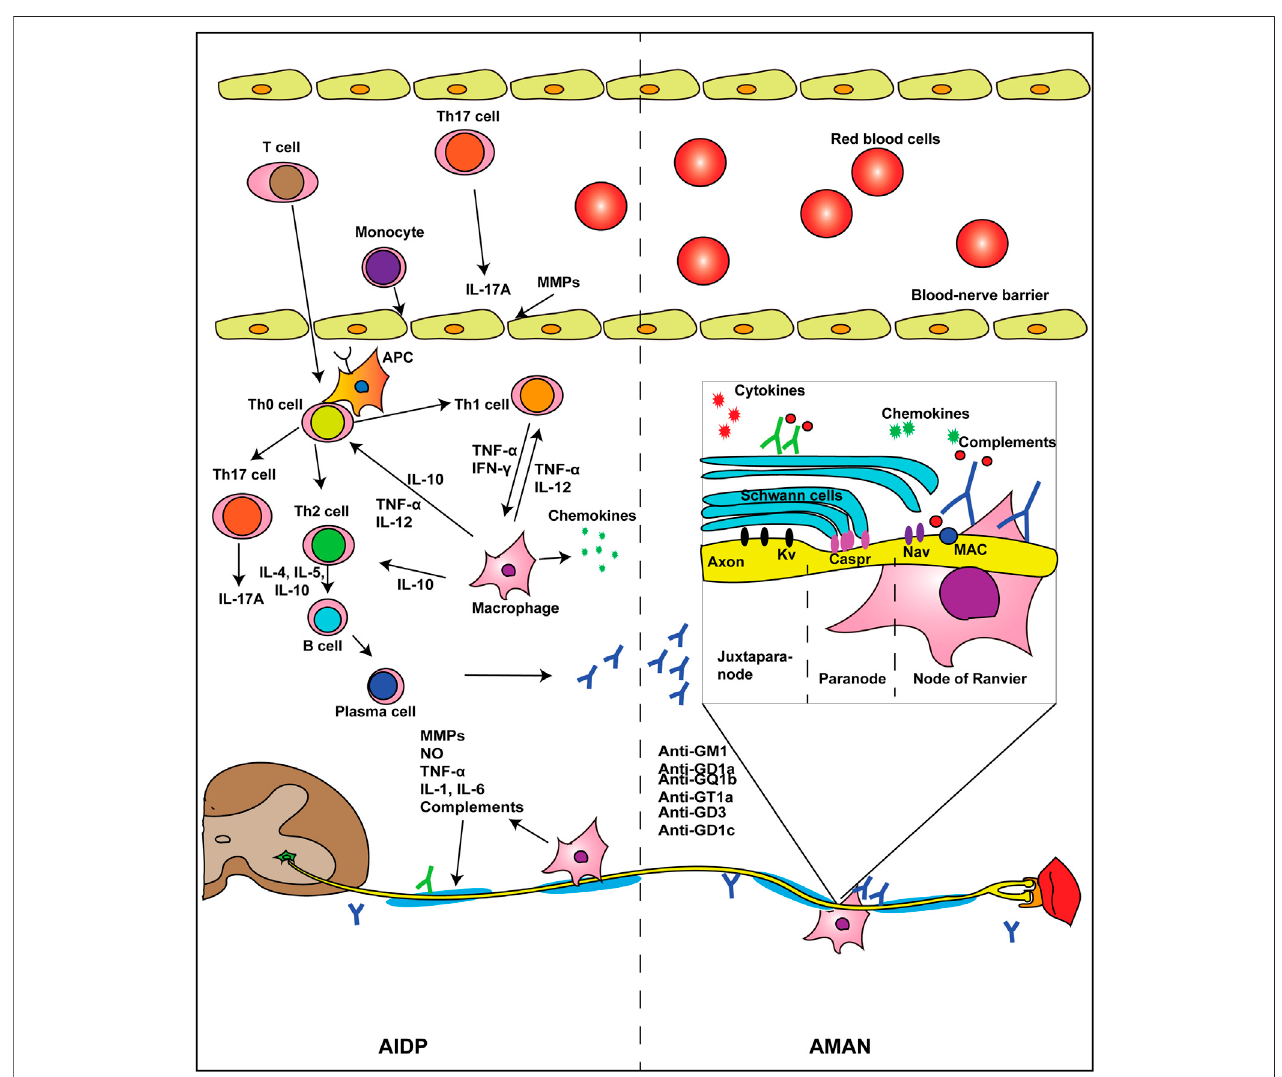
FIGURE 1 | Pathogenesis of AIDP and AMAN. The pathogenesis varies among different subtypes of GBS. In AIDP, Th0 cells go across the BNB and develop into Th1, Th2, or Th17 cells after stimulated by APCs. Th1 cells release TNF- α and IFN- γ , facilitating macrophage recognizing Schwann cells and stripping off the myelin sheath. Th2 cells promote the proliferation and differentiation of B cells. Mature B cells develop into plasma cells and produce pathogenic antibodies. Activated macrophagesinteractwithimmunecellsandcauseastormofin fl ammation-associatedchemokinesandcytokines.InAMAN,antigangliosideantibodiesrecognize thenodeofRanvierandcauseaxonaldegenerationviaMAC.SomeautoantibodiesmayalsotargetSchwanncellsandtriggerdemyelination.Abbreviations:AIDP,acute in fl ammatory demyelinating polyneuropathy; AMAN, acute motor axonal neuropathy; APC, antigen-presenting cell; BNB, blood – nerve barrier; Caspr, contactin- associated protein; FasL, Fas – Fas ligand; GBS, Guillain – Barré syndrome; IFN- γ , interferon γ ; IL, interleukin; Kv, voltage-gated potassium channels; MAC, membrane attack complex; MMPs, metalloproteinases; Nav, voltage-gated sodium channels; NO, nitrogen oxide; TGF- β , transform growth factor- β ; Th cell, T helper cell; TNF- α , tumor necrosis factor- α .